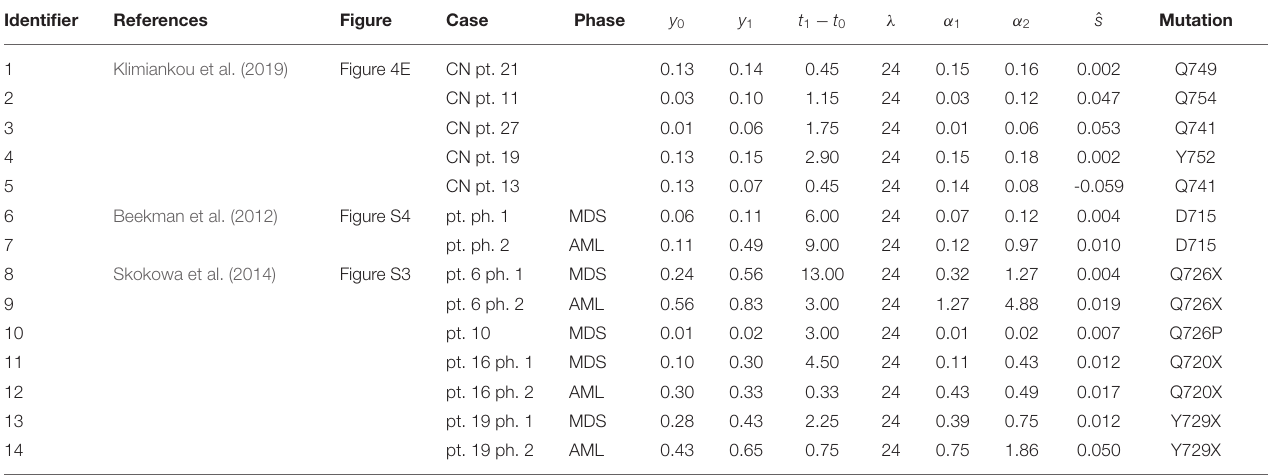
TABLE 1 | Tabular summary of truncated receptor data from three publications, and resulting estimates of selection coefficient for the Moran model without recurrent